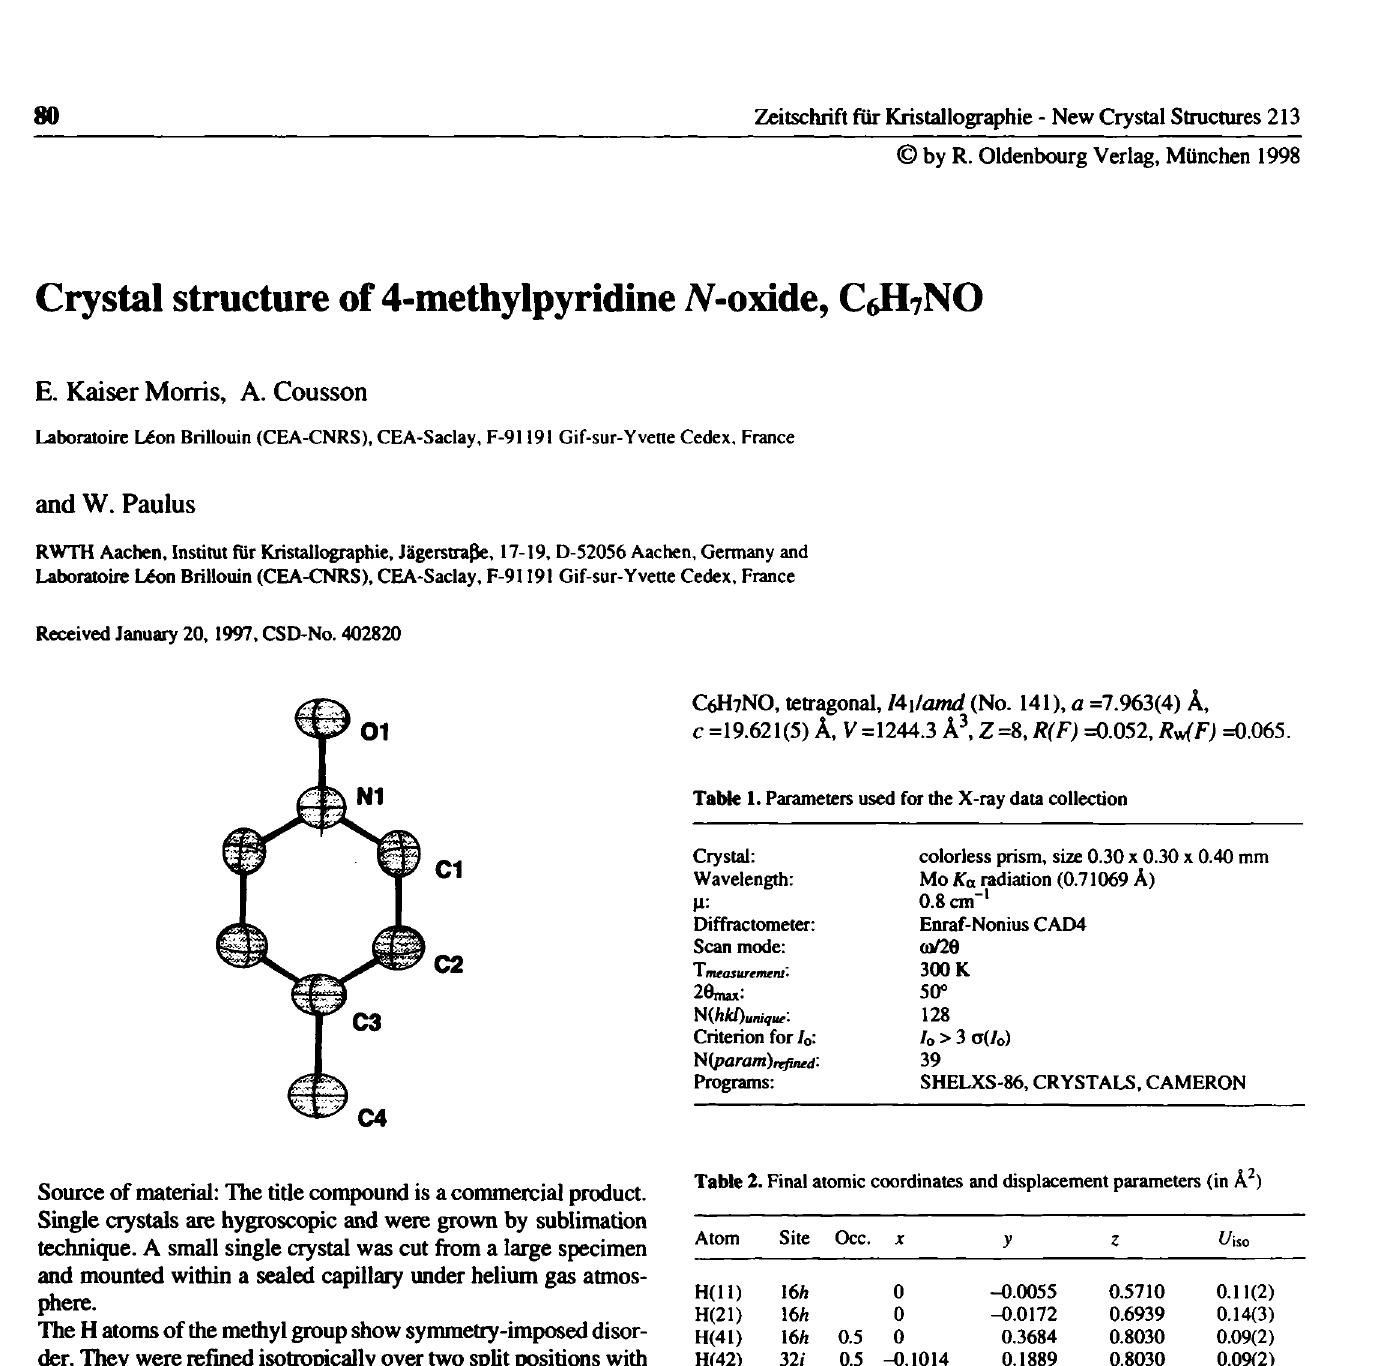
Table 3. Final atomic coordinates and displacement parameters (in Â^)